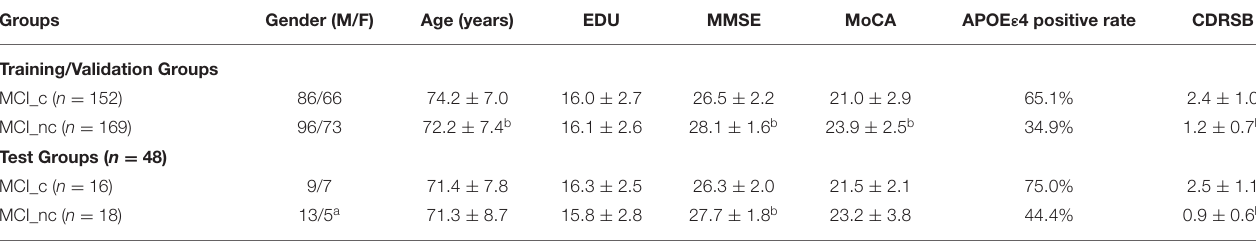
TABLE 1 | Demographic and statistics of clinical assessments at time of data collection. Groups Training/Validation